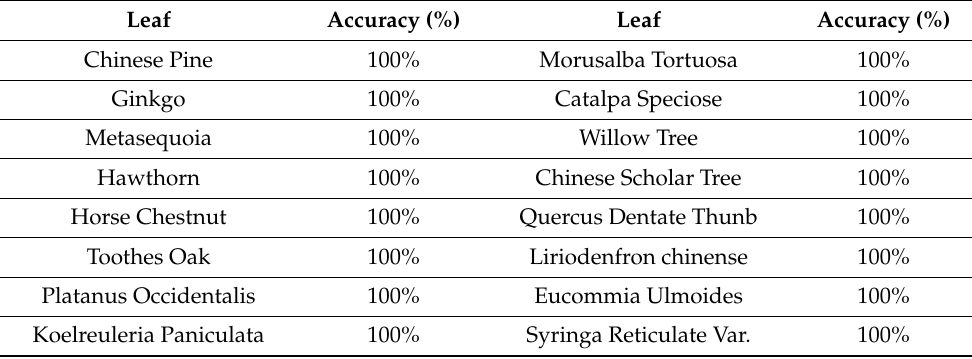
Table 6. Vegetation parameters